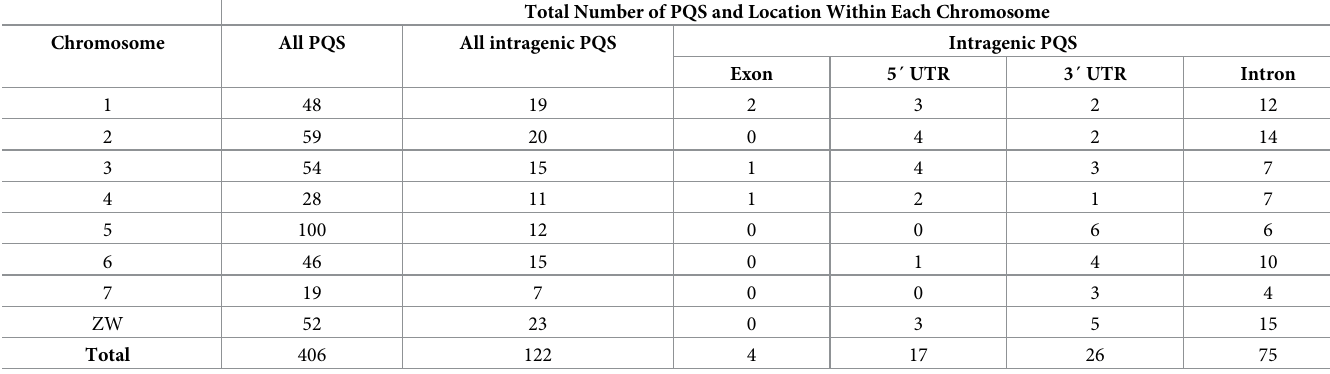
Table 2. PQS numbers and locations within each S . mansoni chromosome. Total Number of PQS and Location Within Each